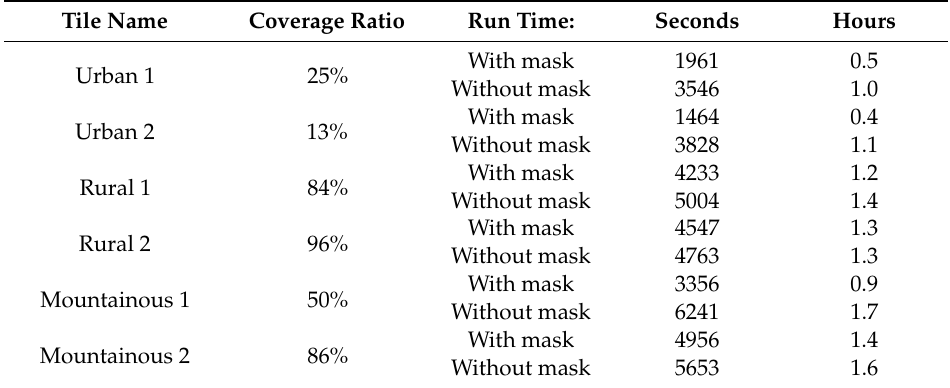
Table 1. Measured run times of representative tiles, with and without the usage of a